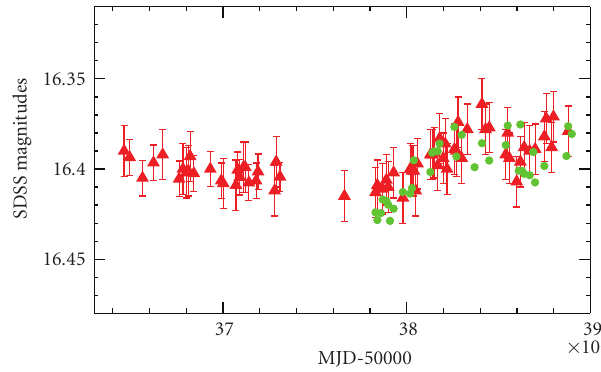
Figure 2: LRT light curves of SBS 0909 + 532A from October 2005 to June 2006. The whole r -band record (red triangles) is compared to the g -band curve (green circles) over the second half of the 2005- 2006 season (it is shifted by − 0.57 mag).